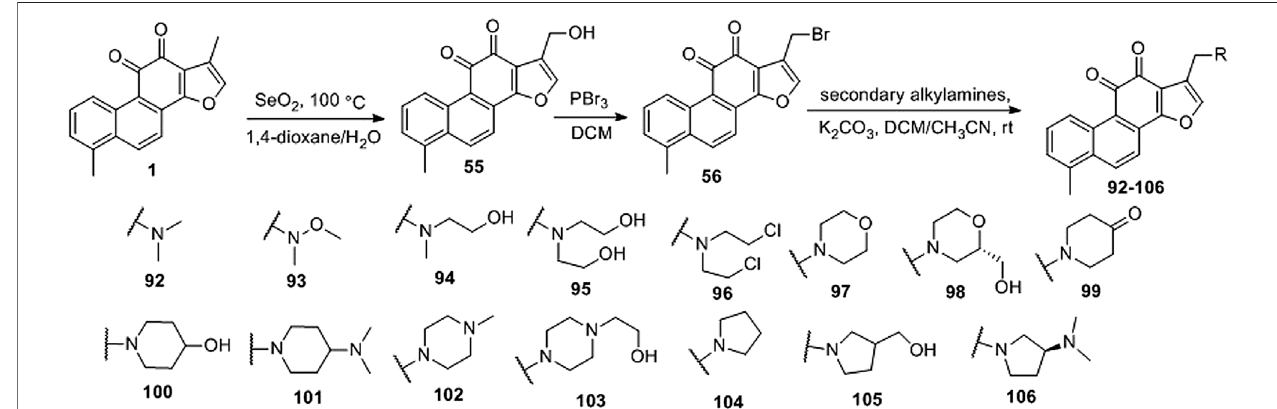
FIGURE 12 | Introducing a nitrogen-containing functional group at the C-17 position.